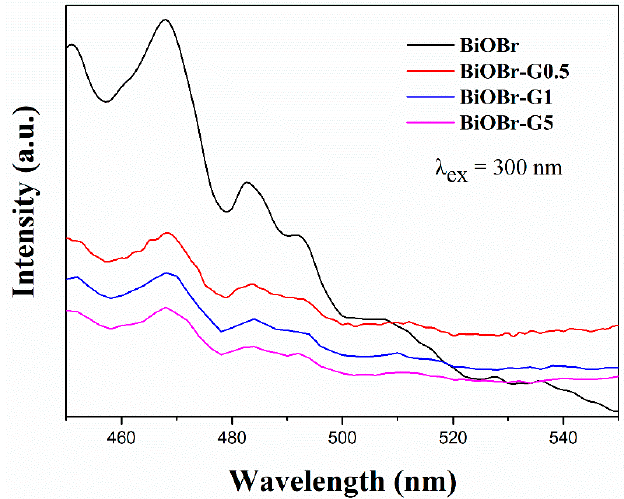
Figure 7. PL spectra of the as-synthesized samples. λ ex is the wavelength of fluorescence excitation